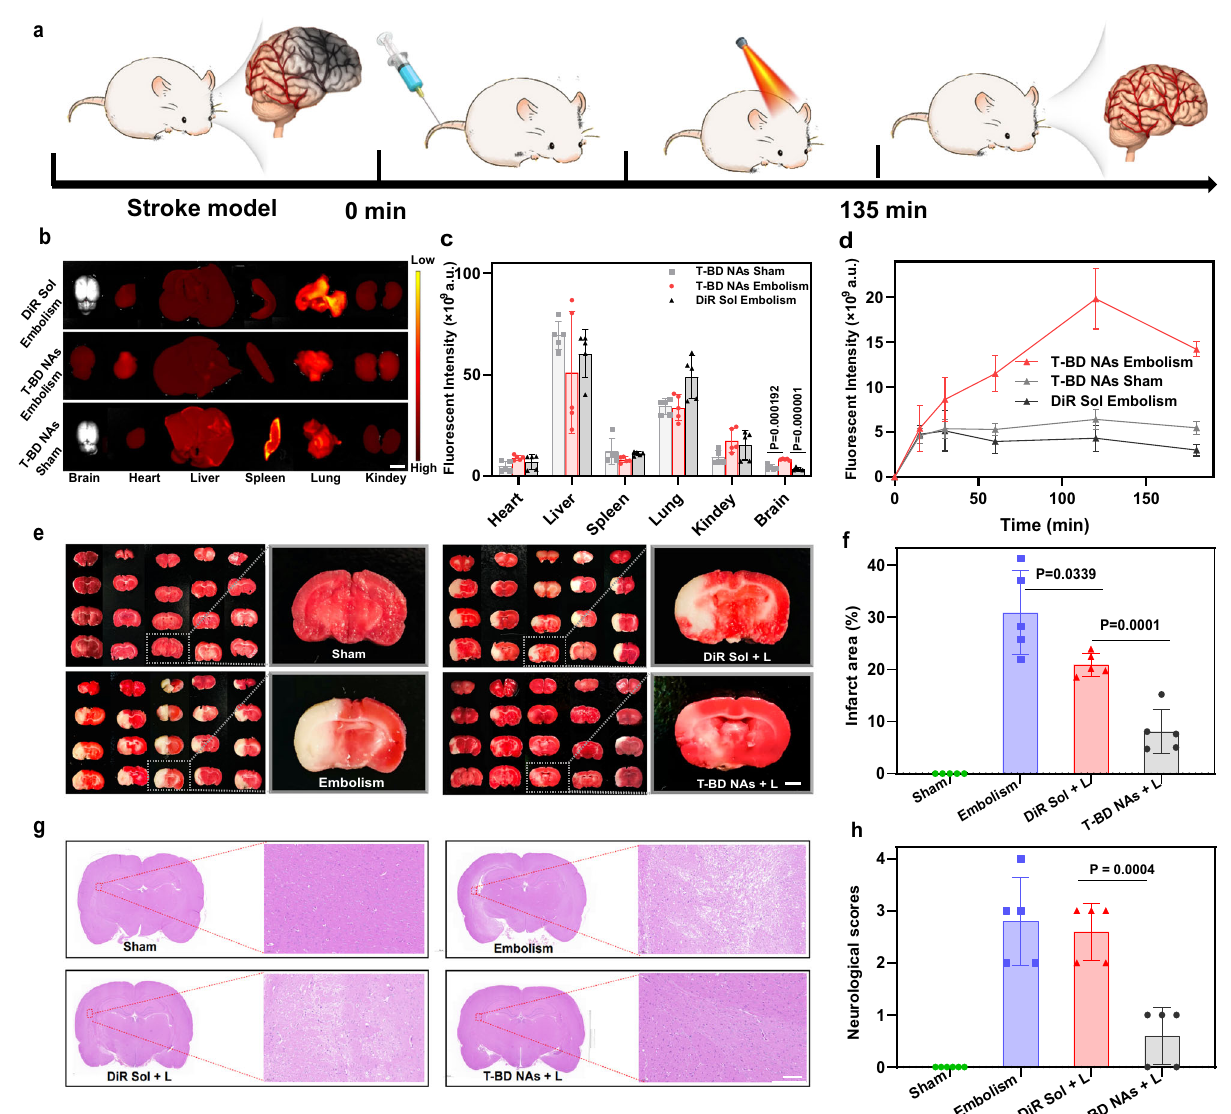
Fig. 7 | Ischemic stroke salvage ( n =5). a Treatment scheme in ischemic stroke salvage. b Representative tissue fl uorescence imaging images of the MCAO model rats(Embolism)andhealthrats(Sham)afterintravenousinjectionofT-BDNAsand DiRSol,scalebar=1cm. c Fluorescence quantitative results of major organs inthe MCAO model rats (Embolism) and health rats (Sham). Data are presented as mean±SD. Source data are provided as a Source Data fi le. One-way ANOVA (one- sided) with Dunnett ’ s multiple comparisons test was used for the analysis of data andadjusted P value. d Brain fl uorescencequantitativeresultsofT-BDNAsandDiR Sol in the MCAO model rats (Embolism) and health rats (Sham) after intravenous injection. Data are presented as mean±SD. Source data are provided as a Source Data fi le. e Representative photographsofTTC-stained brainslicesofSham group, Embolismgroup(0.9%NaCl),DiRSol+Lgroup(2W/cm 2 ,15min),andT-BDNAs+L group (2W/cm 2 , 15min), the infarct area is observed as white, scale bar=1mm.